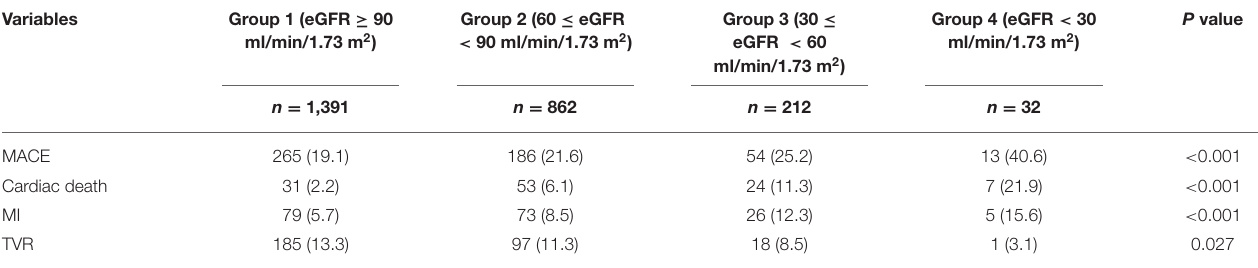
TABLE 3 | Clinical outcomes stratified according to baseline renal function. Variables